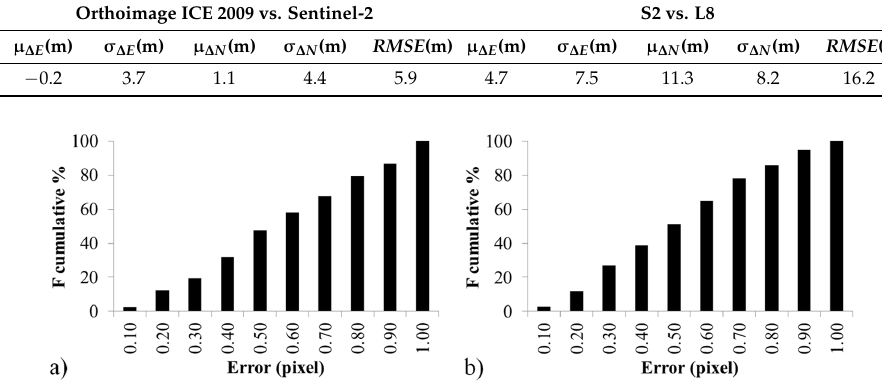
Figure 5. Distribution of cumulative frequency of positioning errors. ( a ) absolute positioning errors; ( b ) relative positioning errors.